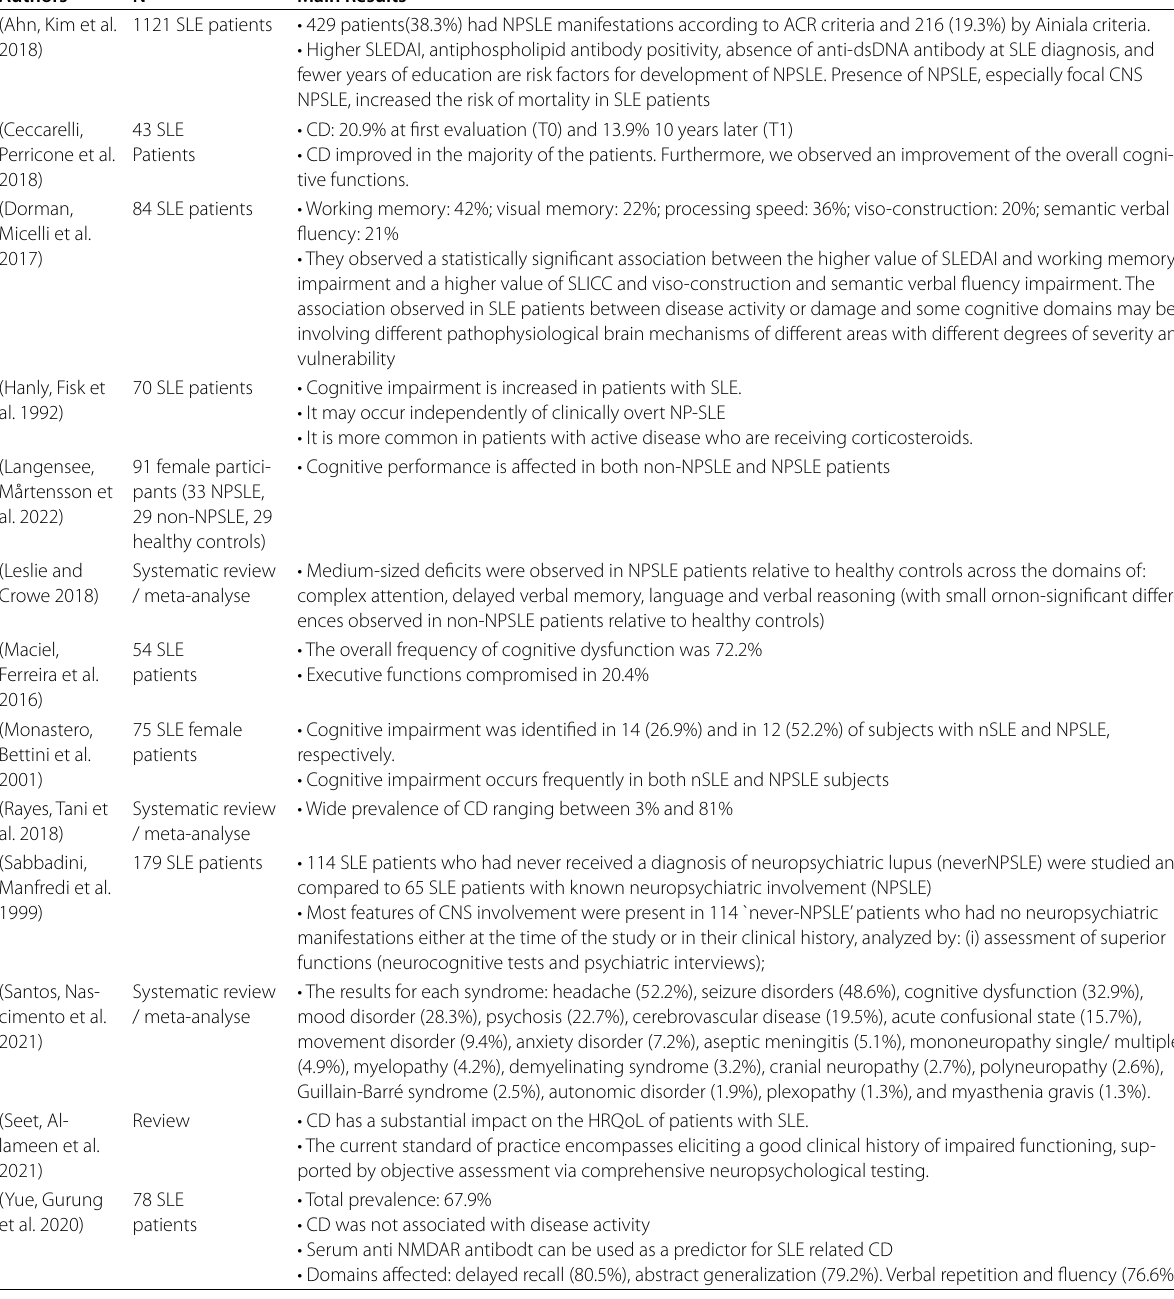
Table 5 Texts on cognitive disorder in SLE used as references and its